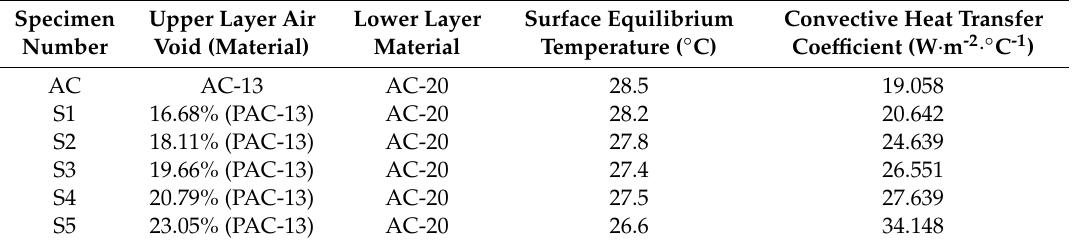
Table 4. Surface equilibrium temperatures and convective heat transfer coefficients.